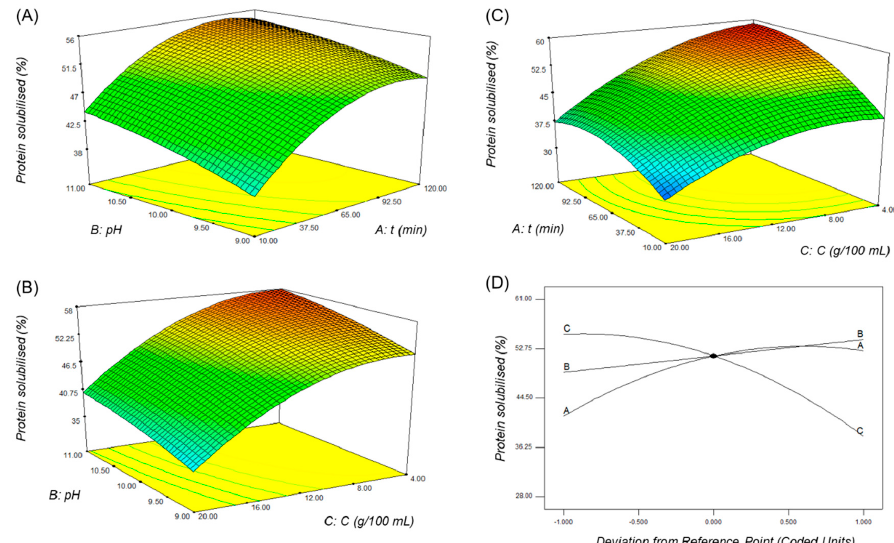
Figure 1. 3D contour plots of percentage protein solubilised from A. platensis , ( A ) extraction time and pH; ( B ) concentration and pH; ( C ) extraction time and concentration. ( D ) Perturbation plot of percentage protein solubilisation—M1. The missing variable is fixed to coded zero level. Actual factors: A (extraction time (min)), B, pH, and C (concentration (g / 100 mL)).